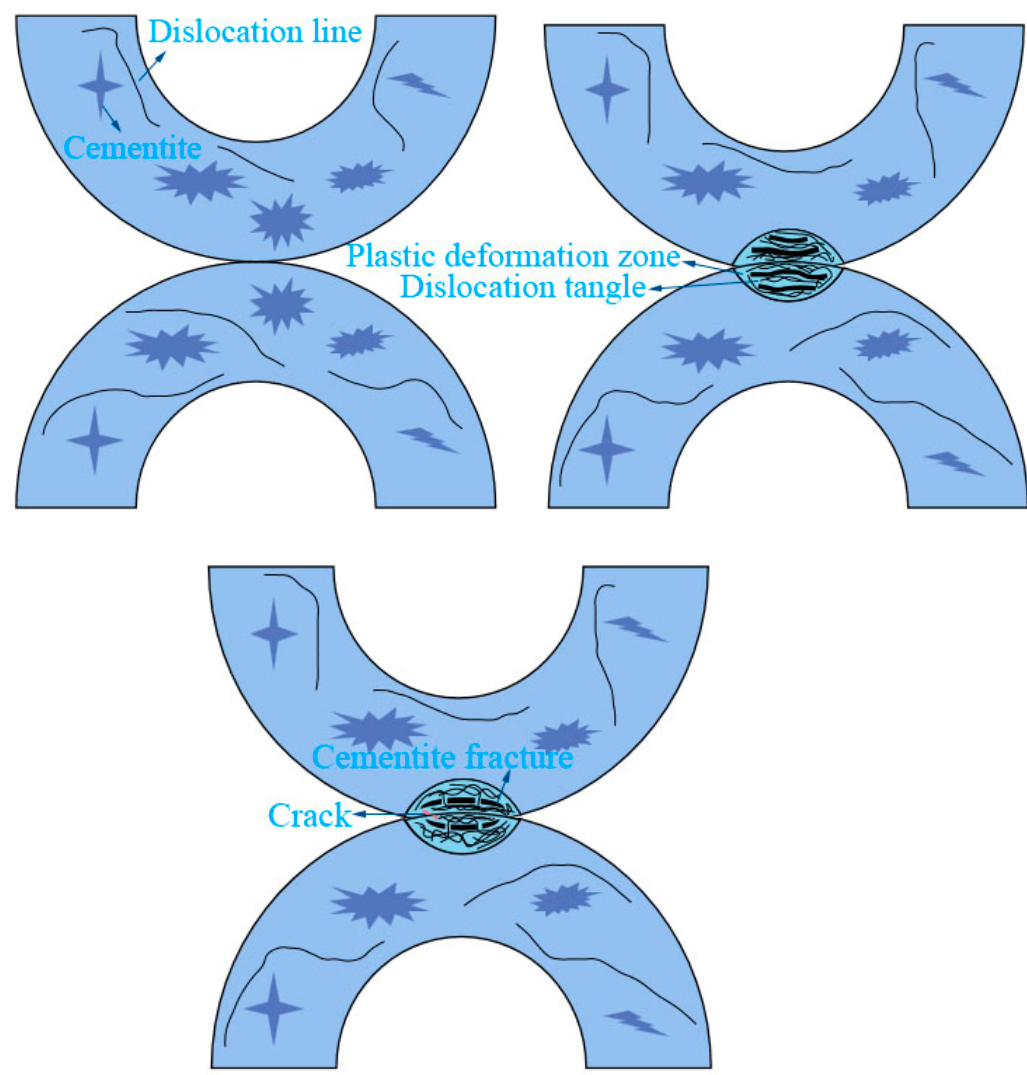
Figure 9. Wear structure transformation of the U-shaped ring.